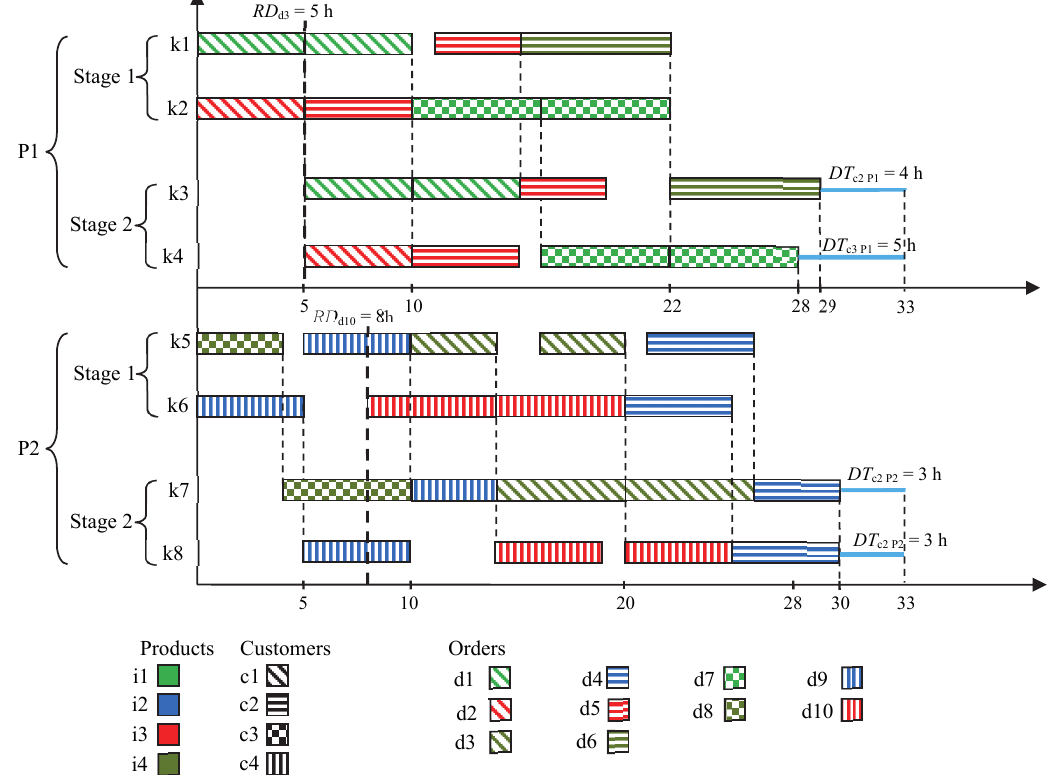
Fig. 4. Gantt chart for competition policy of Example